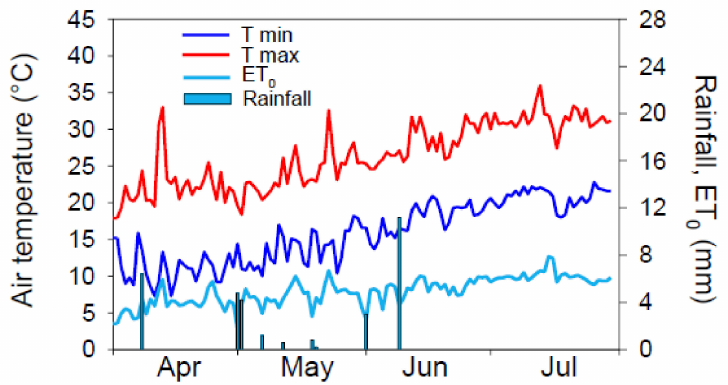
Figure 1. Meteorological course (minimum-Tmin and maximum-Tmax air temperature, rainfall, reference evapotranspiration-ET 0 ) recorded in the experimental site from April to July